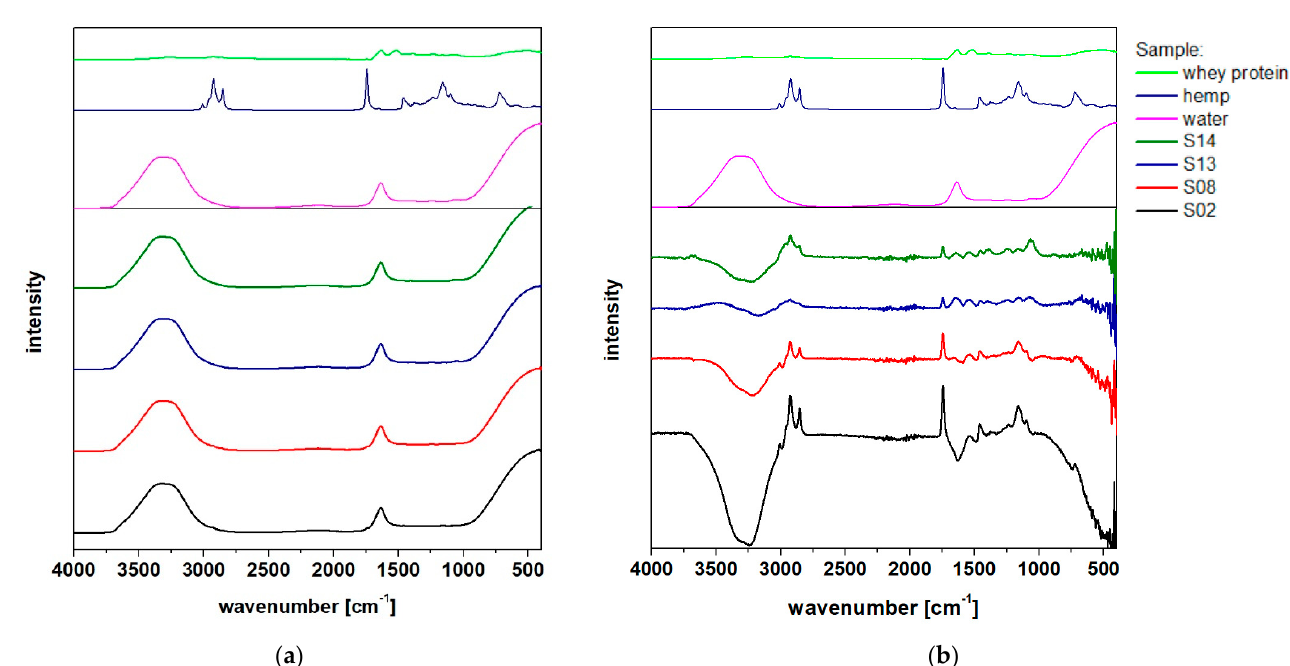
Figure 5. FTIR spectra of investigated samples with ( a ) air or ( b ) water as the background.